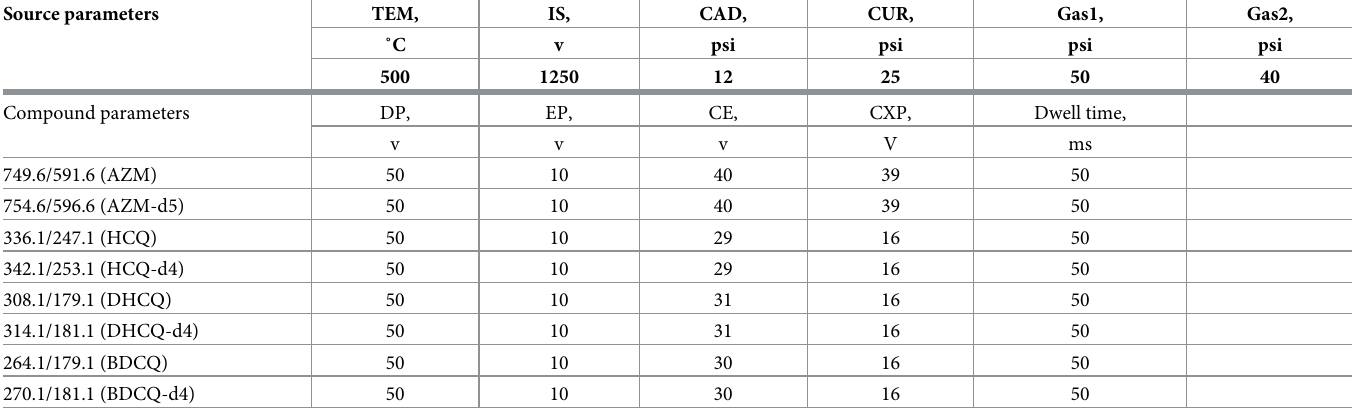
Table 1. Optimized MS/MS parameters.